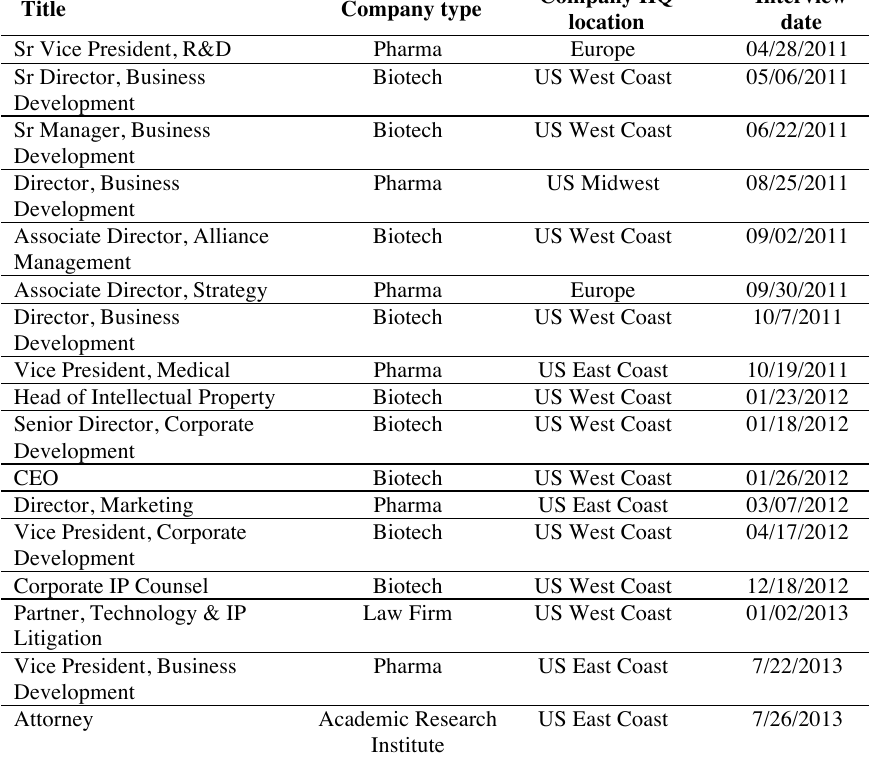
Table 1. List of pharmaceutical industry interviews